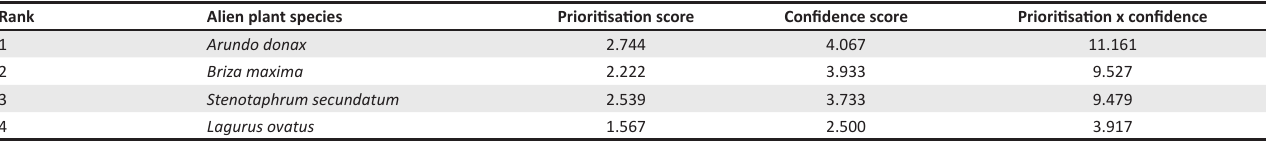
TABLE 3: The prioritisation scores of alien plants species surveyed on the trails in the Silvermine section of the Table Mountain National Park. The scores were calculated using the alien species prioritisation system. Rank Alien plant